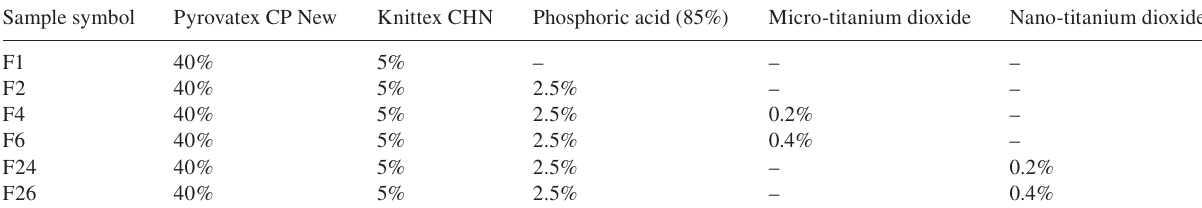
*Concentration percentage measured based on weight of